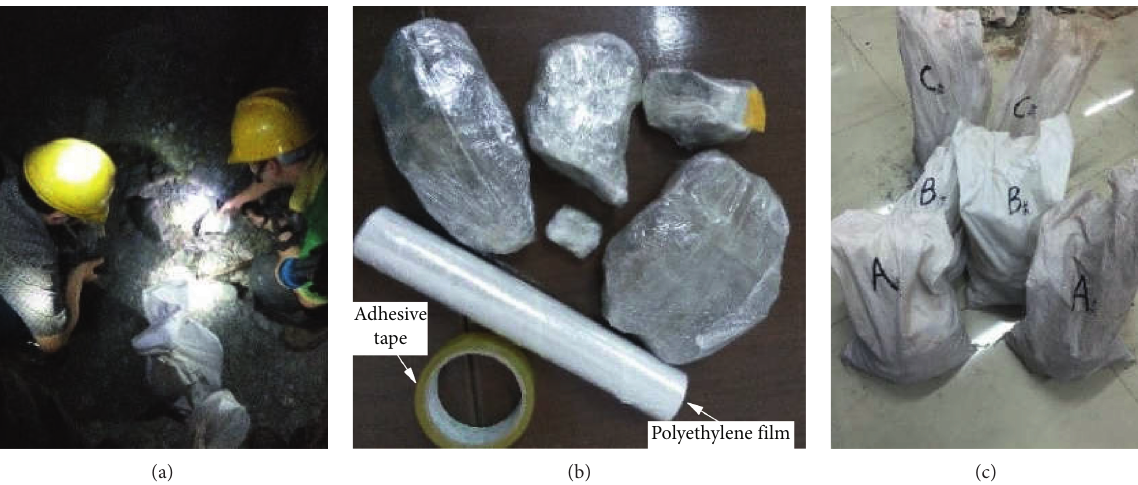
Figure 1: Photos illustrating the field sampling steps. (a) Multipoint sampling; (b) wrap and seal; (c) mark ore sample.